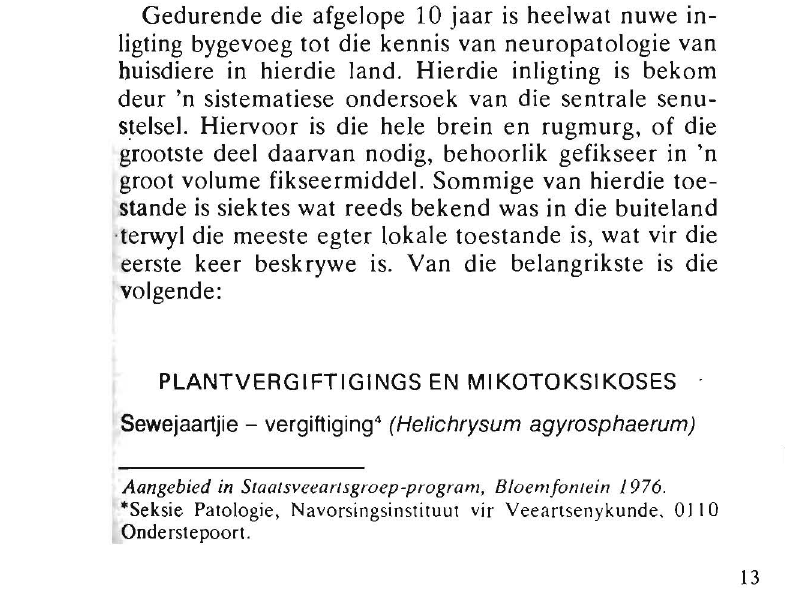
Maldronksiekle 20 (Solanum kwebense) Veroorsaak 'n vakuolisasie van groter neurone,